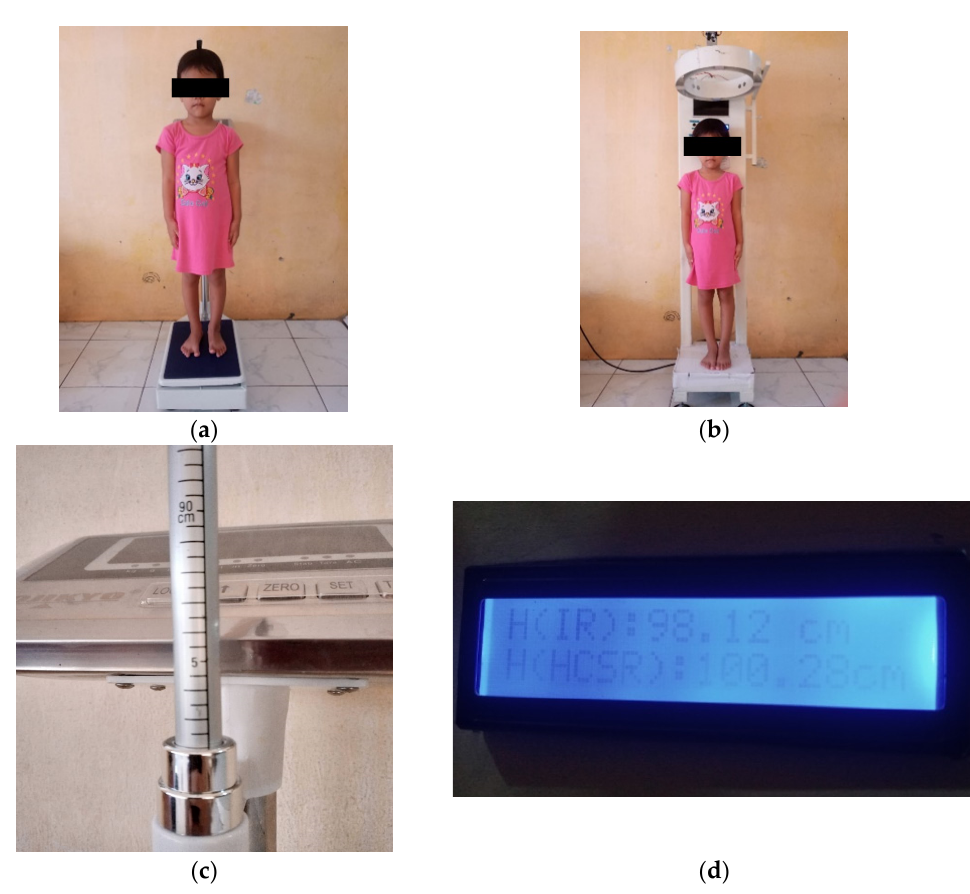
Figure 12. Height measurement ( a ) using a stadiometer; ( b ) using sensor HCSR-04 and IR GP2Y0A2; ( c ) scale on the stadiometer; and ( d ) display of height measurement on LCD 6 × 2. Based on the tests carried out in Table 3, the average error of height measurement using the sharp IR sensor GP2Y0A21 is 0.33%. Measurement of height using the sharp IR sensor GP2Y0A21 has an average error value of 2.19%. Table 3. Comparison of height measurement results using conventional tools (a stadiometer), ultra- sonic sensors (US) and infrared sensors (IR).